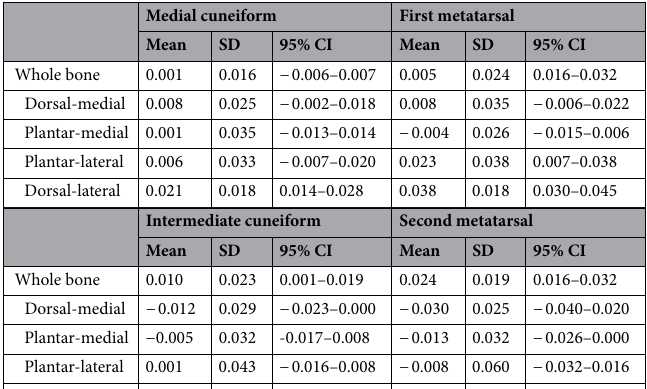
Table 3. Gaussian curvature measures of the whole surface and each quadrant of the articular surfaces within the first and second TMT joints. Zero represents a flat surface, positive values show convex curvature and negative values show concave curvature.